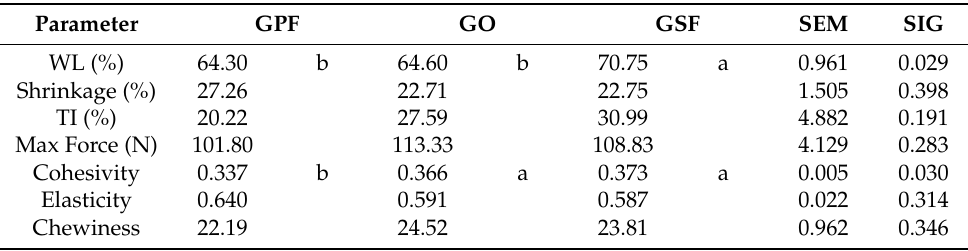
Table 4. Weight loss and change of shape due to cooking and TPA of goat meat cooked burgers with fat